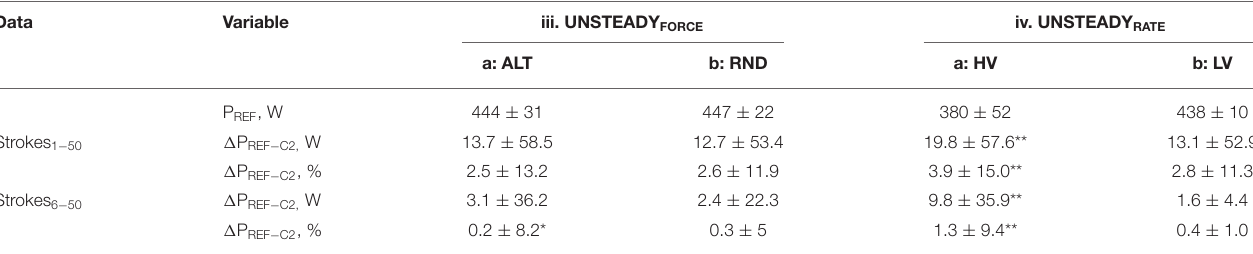
TABLE 2 | Mean differences in mechanical power output between the reference system of a test rig for air-braked rowing ergometers and the Concept 2 Indoor Rower’s PM5 Monitor during unsteady simulated rowing.